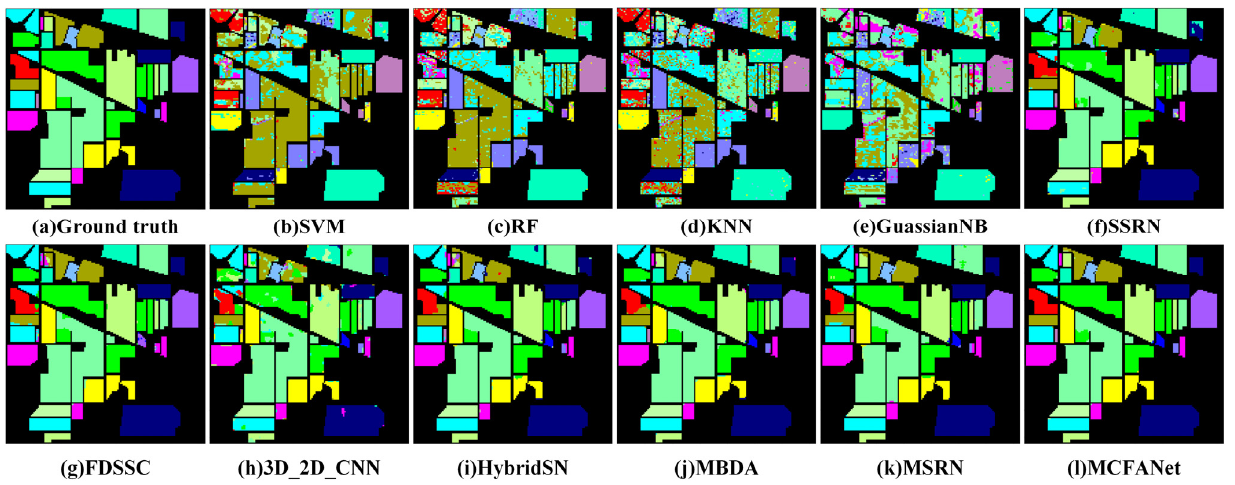
Figure 13. The visual classification maps of diverse approaches on the IP dataset.